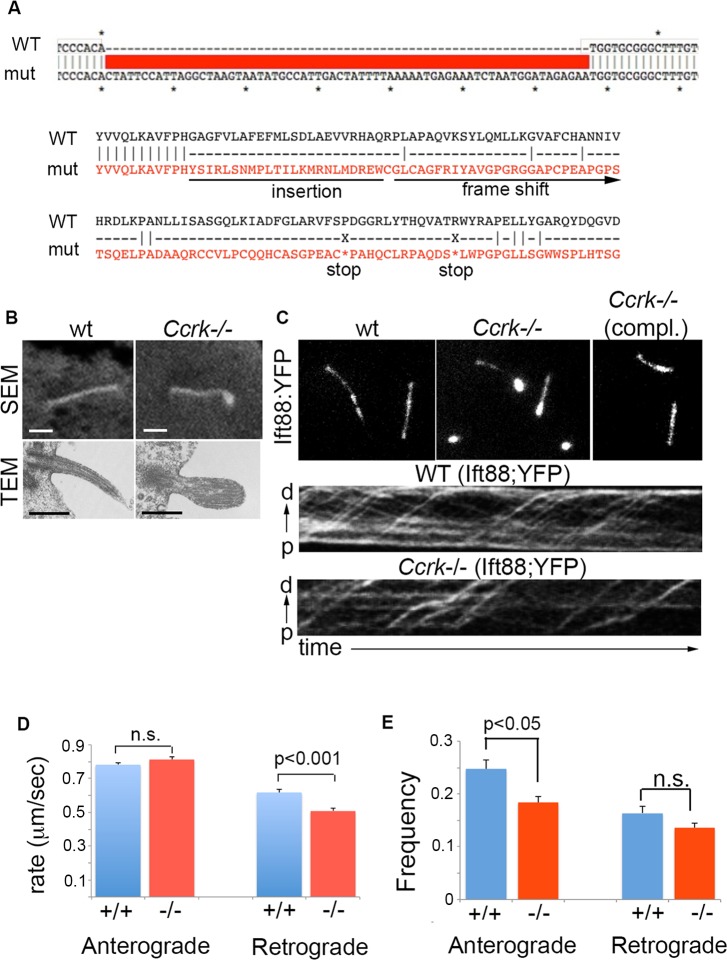
Ciliary phenotypes and IFT assays in wild-type and Ccrk mutant IMCD3 cells harboring an IFT reporter.(A) Ccrk mutant IMCD3 cells (expressing an IFT88::YFP construct)were generated by CRISPR/Cas9 mutagenesis. A clone with a homozygous 67 bp insertion (causing a frame shift and multiple nonsense codons downstream) was identified and analyzed further. (B) Scanning and transmission electron microscopic analysis of wild-type and Ccrk mutant IMCD3 cilia. The mutant cilia showed swelling at their distal ends. (C) IFT88::YFP expression in wild-type and Ccrk mutant IMCD cells. The Ccrk mutant cells uniformly showed accumulation of IFT88::YFP at their distal ends. Transfection of the mutant cells with a wild-type Ccrk expression construct rescued this phenotype. Kymographs from live imaging of IFT88::YFP particle movement in wild-type and Ccrk mutant cilia are shown (distal cilia ends at the top, time increases from left to right). Anterograde transport occasionally showed abrupt changes in speed in the mutants. Rates (D) and frequencies (E) of anterograde and retrograde IFT particle movement were determined from the kymographs. Speed quantitation was determined from 235 and 61 particles (anterograde) and 74 and 25 particles (retrograde) in wild-type and Ccrk mutant cilia, respectively. Frequency quantitation was determined from 45 and 64 cilia movies from wild-type and Ccrk mutant cells, respectively. Error bars represent standard error of the mean. Statistical analysis represents results from Student’s t-test. Scale bars in B are 1 μm.